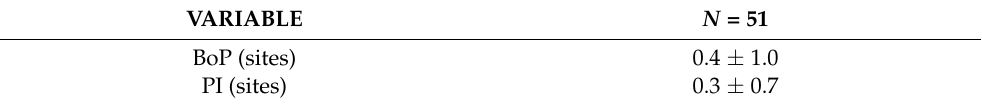
Table 2. Variables related to the tooth at baseline.